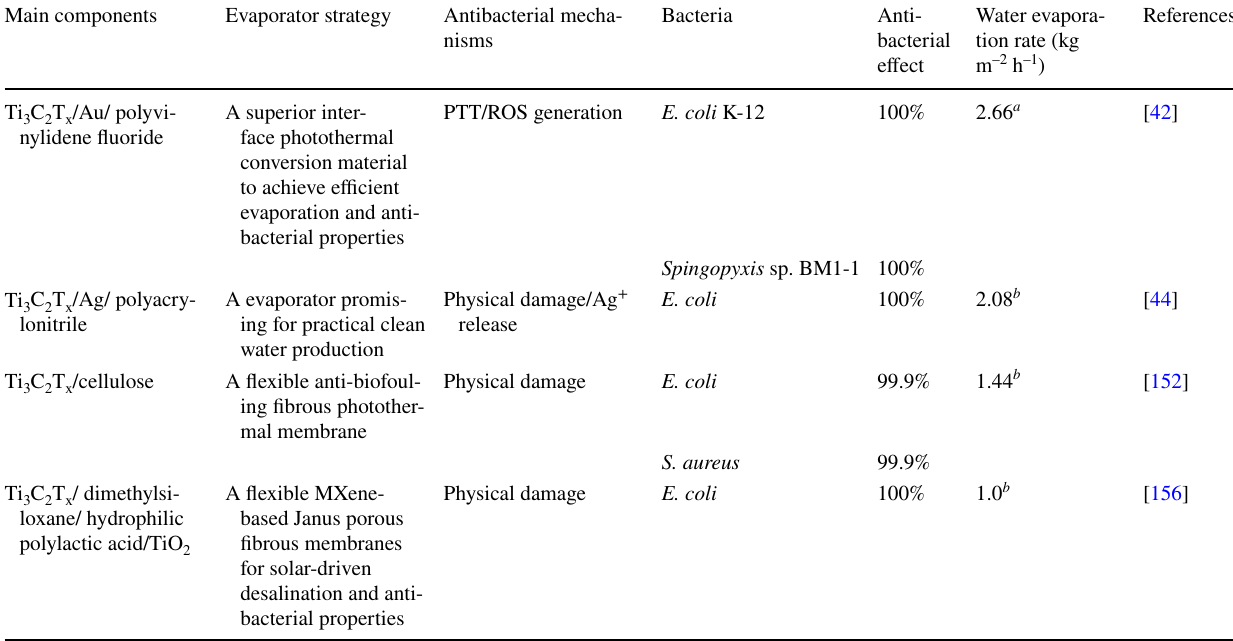
Table 5 Summary of antibacterial applications using MXenes-containing